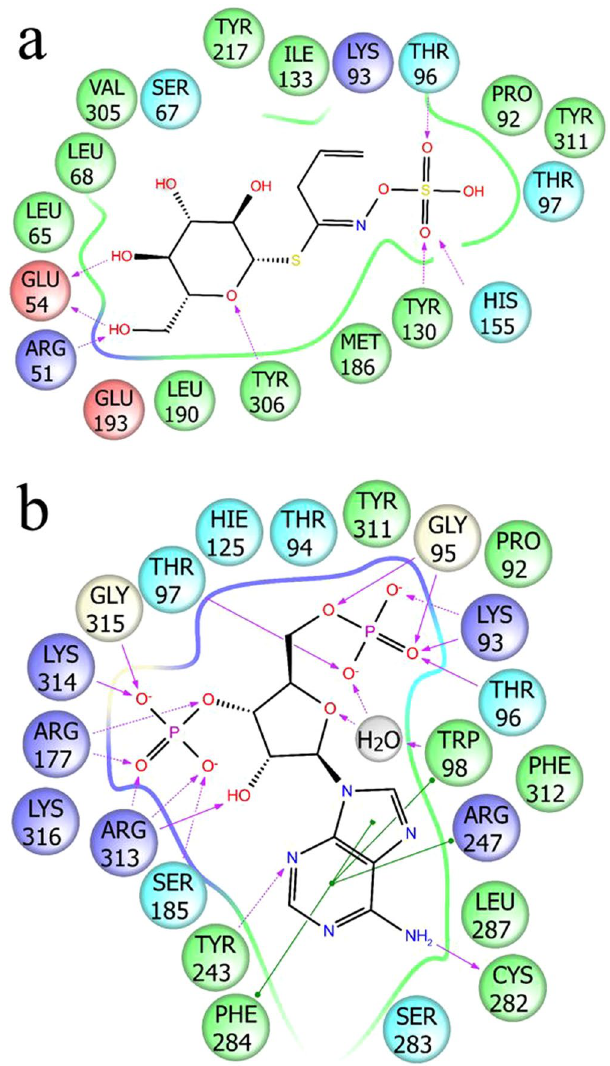
Figure 5. Ligand binding sites ( a ) sinigrin binding site and ( b ) PAP binding site with and π - π stacking (green lines) interaction and hydrogen bonds to residue backbone (purple arrows) and side chains (dotted purple arrows).